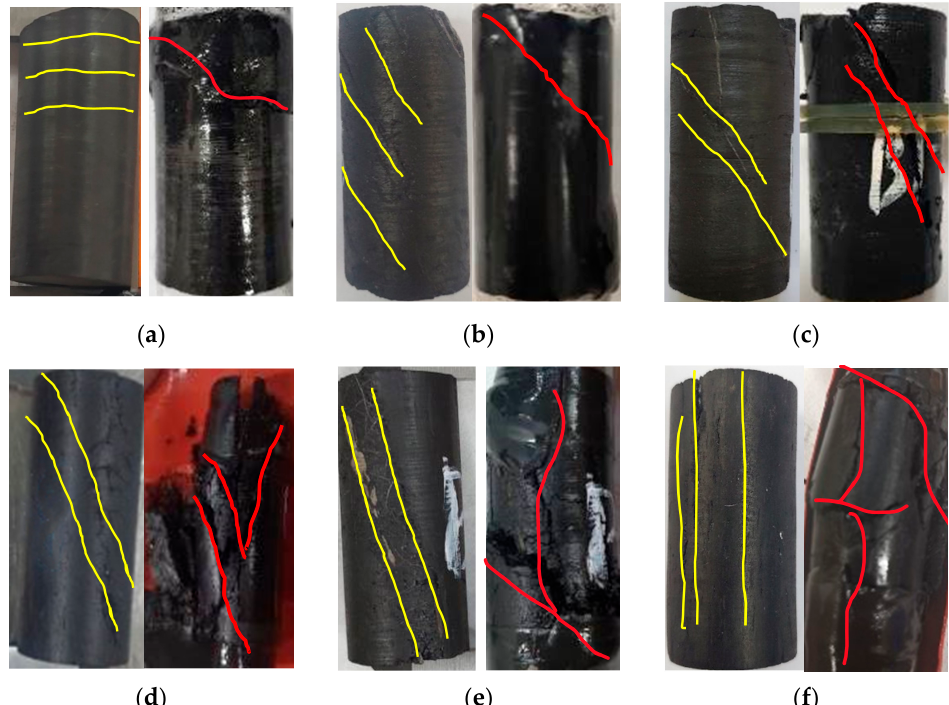
Figure 11. Comparison of coal samples with different bedding angles before and after failure. ( a ) 0°. ( b ) 30°. ( c ) 45°. ( d ) 60°. ( e ) 75°. ( f ) 90°.